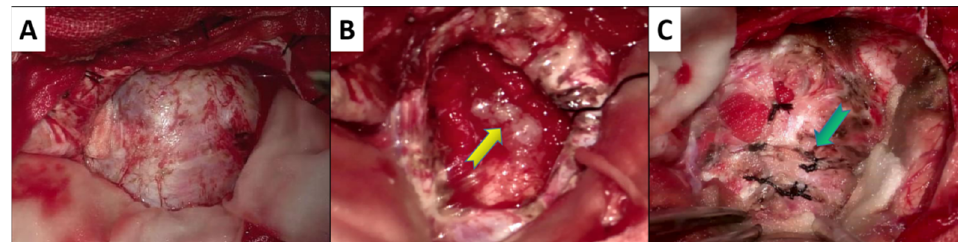
Figure 3. Surgical resection of parasellar chondrosarcoma. ( A ) Tumor exposure; ( B ) intraoperative condition; ( C ) total tumor resection. After the tumor was exposed, it was found that the tumor was located in the cavernous sinus ( A ), and local calcification could be seen inside the tumor. The yellow arrow shows the calcified part ( B ). After the tumor was removed, the green arrow shows that the gel sponge was filled into the cavernous sinus for full hemostasis, and the lateral wall of the cavernous sinus was sutured to prevent the gel sponge from falling into the cavernous sinus due to the cerebrospinal fluid been surrounded ( C ).